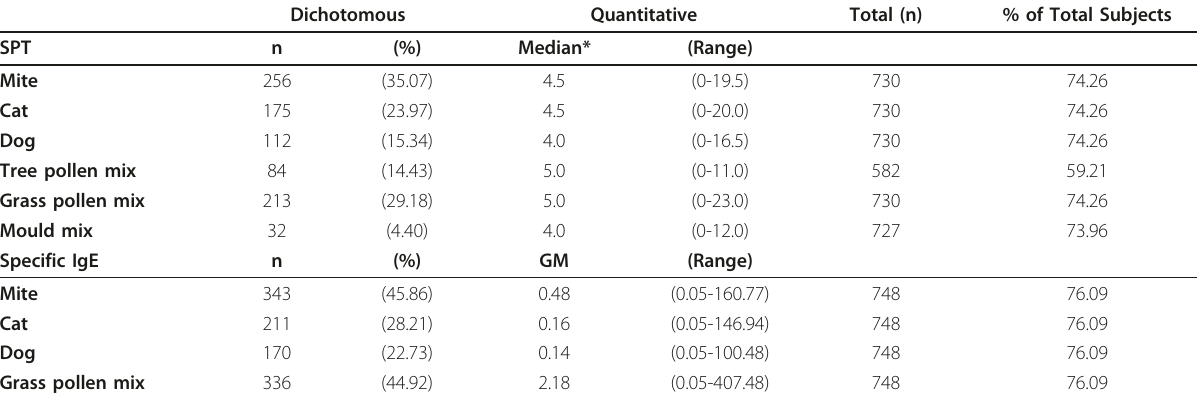
Table 2 Allergen sensitisation: Dichotomous definitions on SPT and sIgE, SPT wheal mean diameters (WMD, mm) and sIgE level (kU A /l) Dichotomous